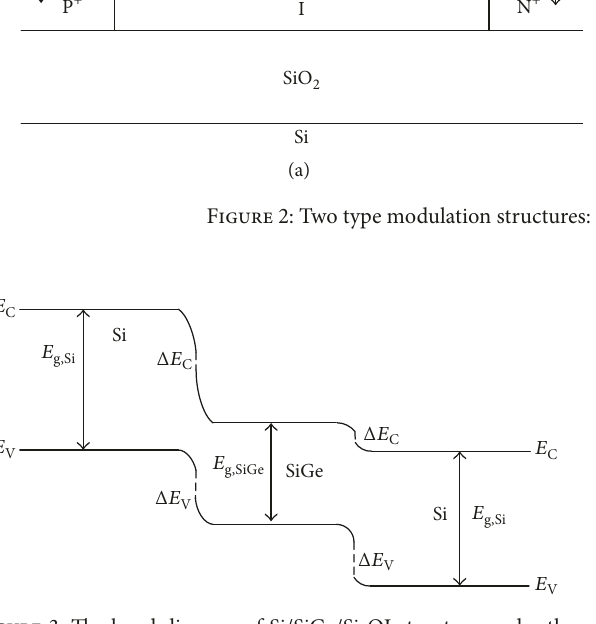
Figure 3: The band diagram of Si/SiGe/Si-OI structure under the equilibrium